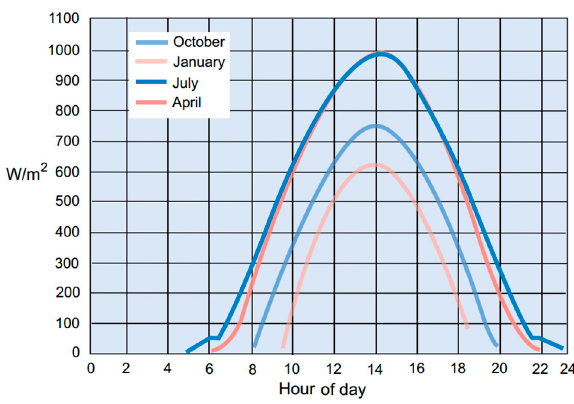
Figure 15. Typical power generation curves for a solar panel in the UK on a cloudless day; adapted from [60].